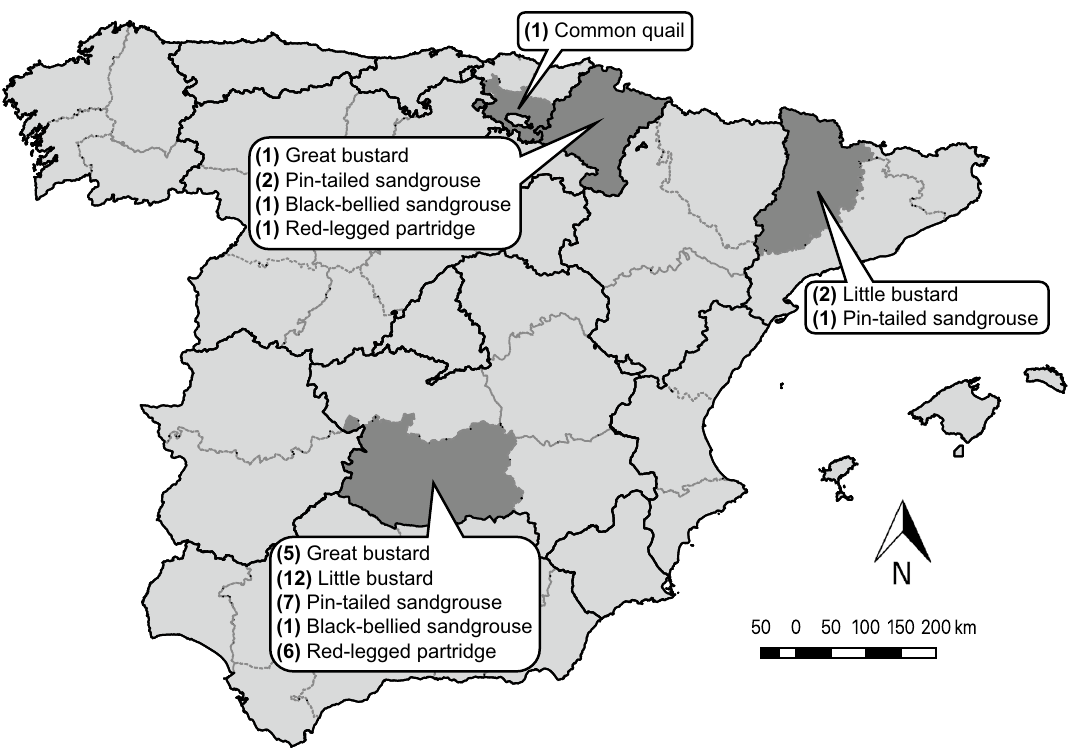
Figure 8. Map of Spanish regions with the spatial distribution of each species samples. The number of flocks per species sampled in each region is shown in brackets. This map was generated using QGIS v3.10 57